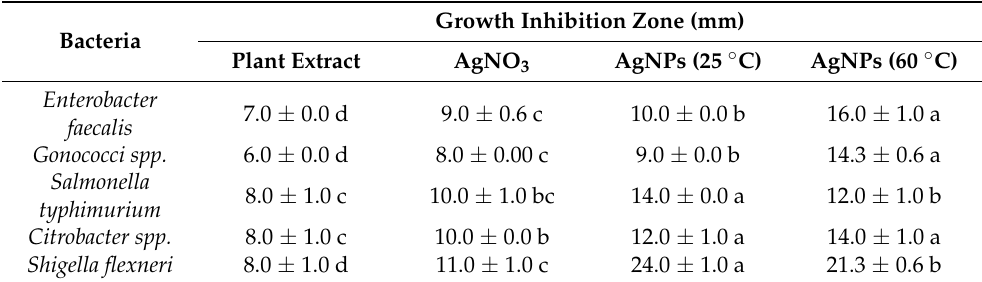
Values are means and standard deviations of three independent data sets. Different letters represent significant differences between the various extraction conditions. ( p < 0.05) for each bacterial strain. Ciprofloxacin was used as a standard antibiotic, showing an inhibition zone of 26.55 ± 0.25 mm.